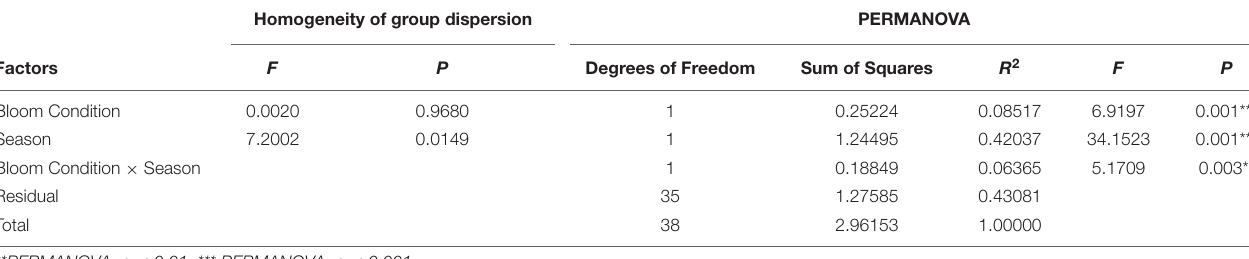
TABLE 4 | Homogeneity of group dispersion and permutational multivariate analysis of variance (PERMANOVA) results of prey community structure in the Sarasota Bay study area, from 2004 to 2019, in relation to bloom condition and season. Homogeneity of group dispersion